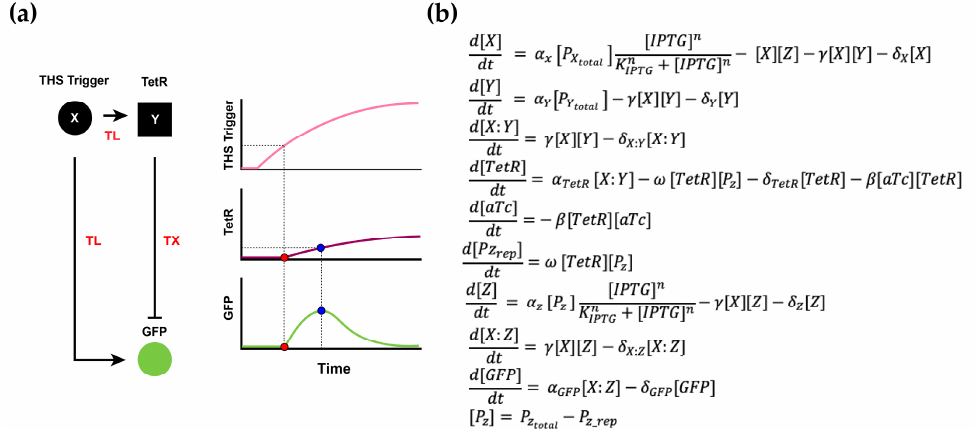
Figure 4. RNA–protein hybrid IFFL design and mathematical model. ( a ) The pulse generator design was implemented by fast THS activation and slow TetR repression. THS trigger activates GFP expression immediately while delayed TetR formation causes a pulse in the rate of GFP production. ( b ) Mathematical model for the RNA–protein hybrid circuit. Note, TX stands for transcription and TL stands for translation in the diagram. The red dot in the diagram indicates the time delay between the production of THS trigger from X and activation of Y and Z expression, and the blue dot indicates when the inhibition by TetR has an effect on GFP expression for a pulse to emerge in the system.